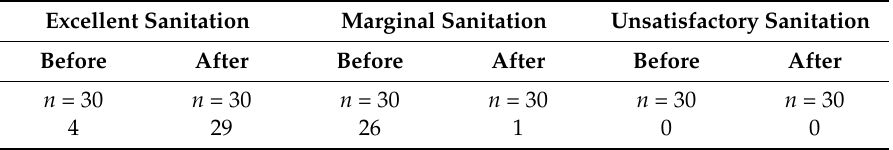
Table 2. Gram stain test to determine the presence of Gram positive bacteria and Gram negative bacteria on the experimental